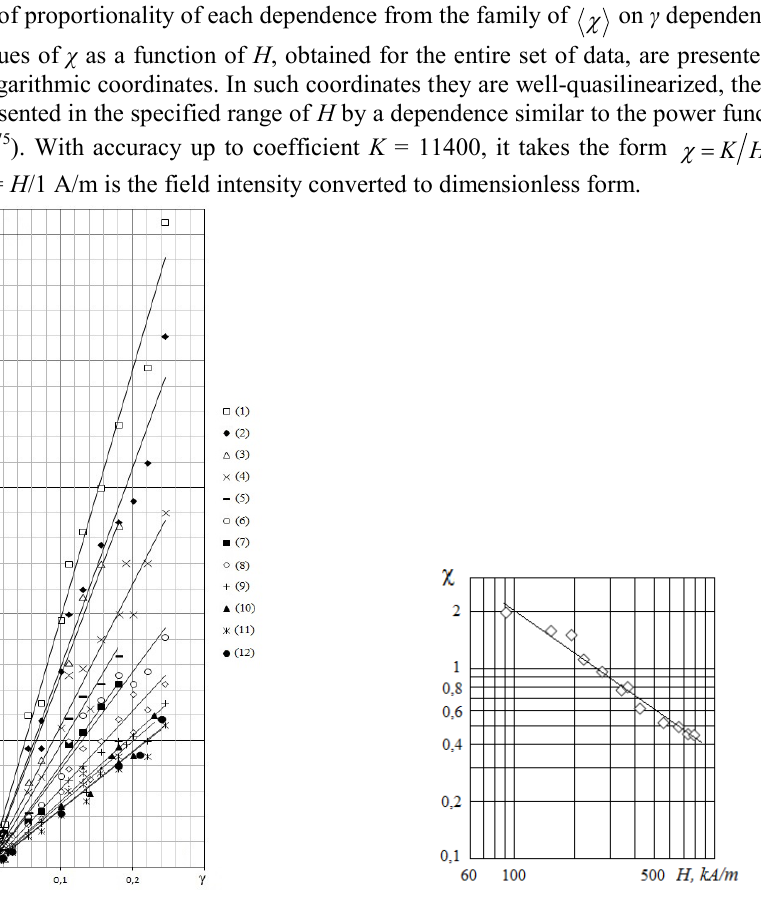
Fig.5. Effect of the volume fraction of Fig.6. Dependence of the